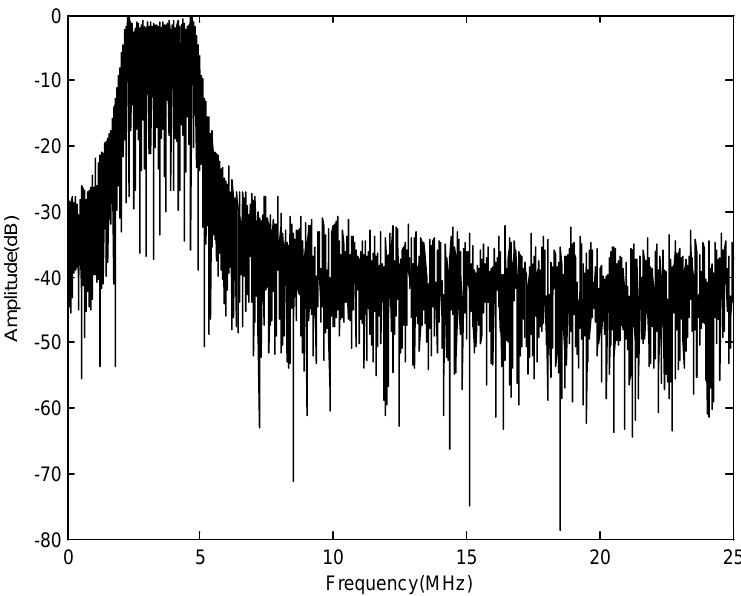
Figure 10. Spectrum of truncated LFM signal.